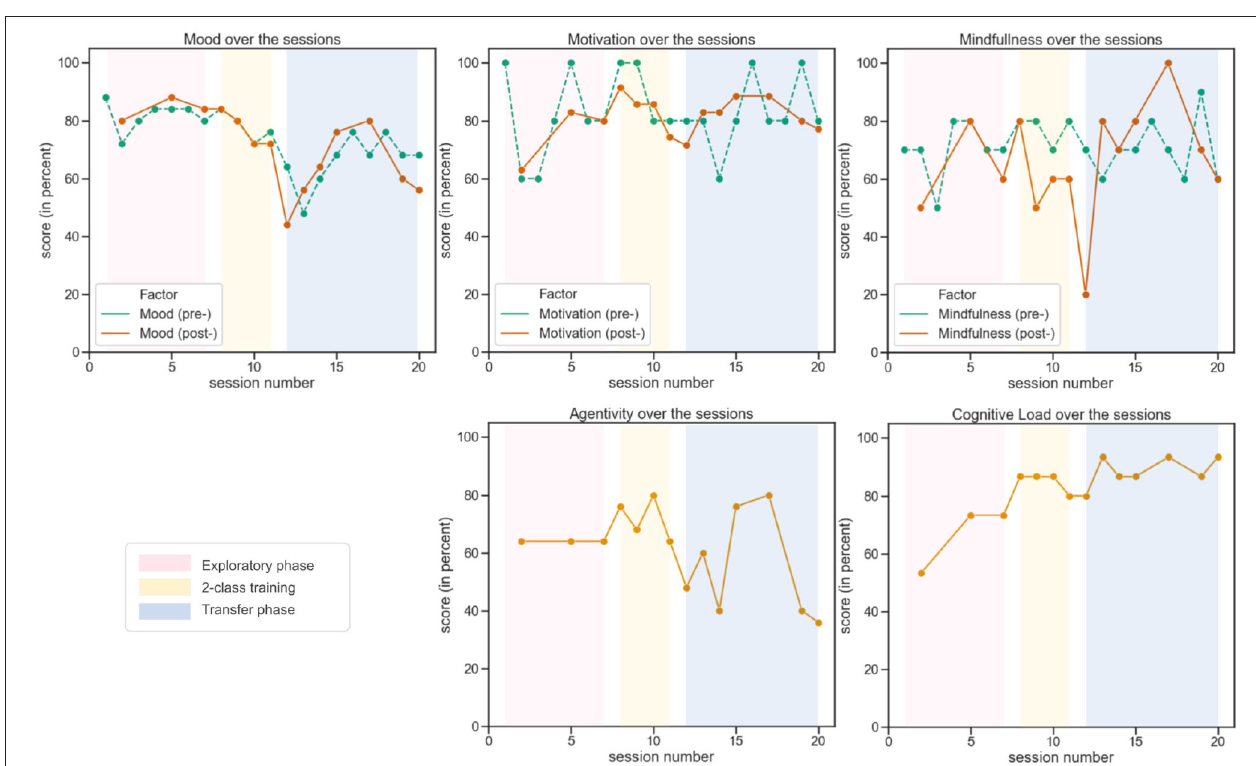
FIGURE 13 | Evolution over sessions of user experience metrics, i.e., user mood, motivation, mindfulness, agency, and cognitive load.